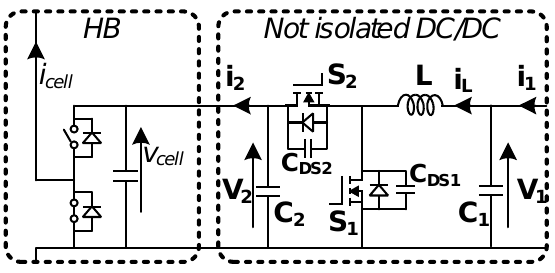
Figure 1. Basic cell structure of a multilevel converter integrating energy resources. This cell is composed of a Half-Bridge (HB) cell and synchronous boost DC/DC converter connected in cascade [13].